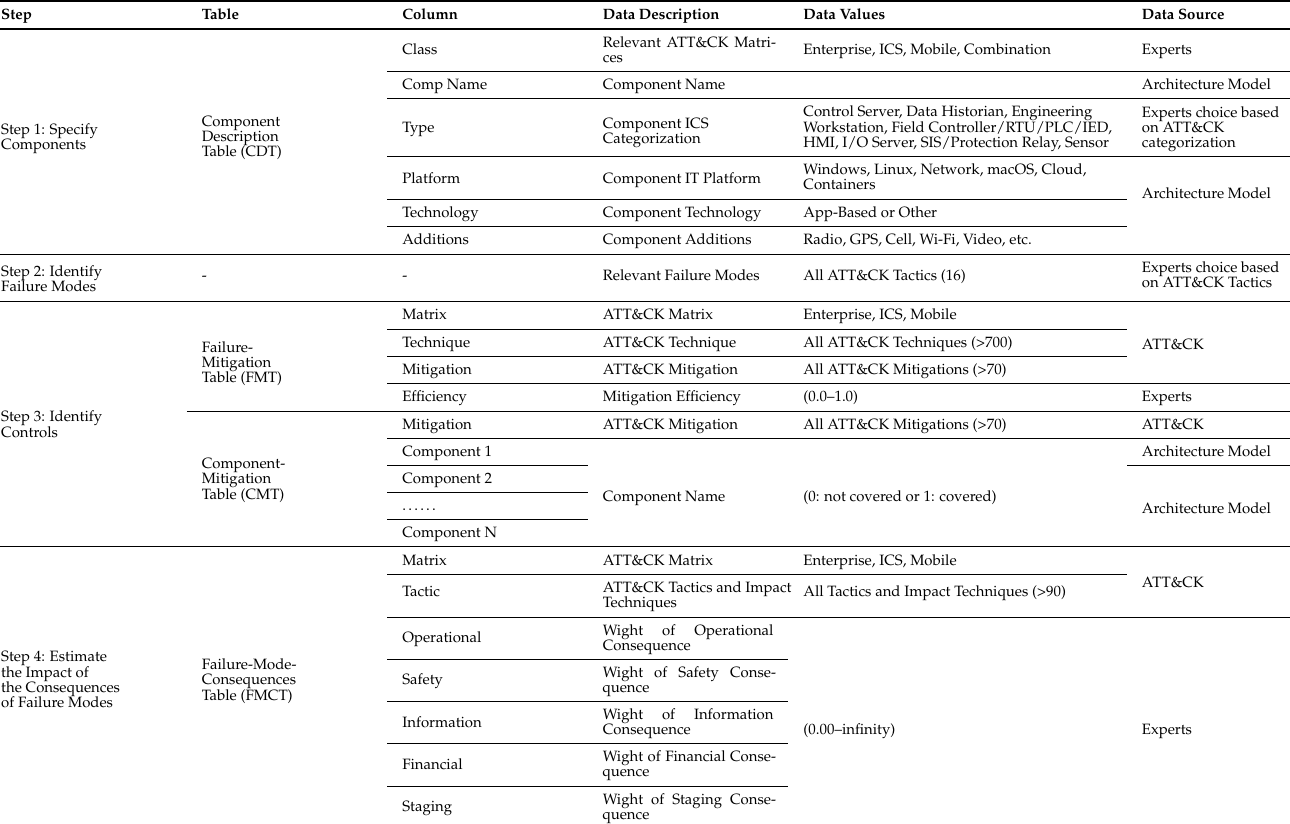
Table A1. Detailed description of the FMECA-ATT&CK steps, tables, data types, and knowl- edge